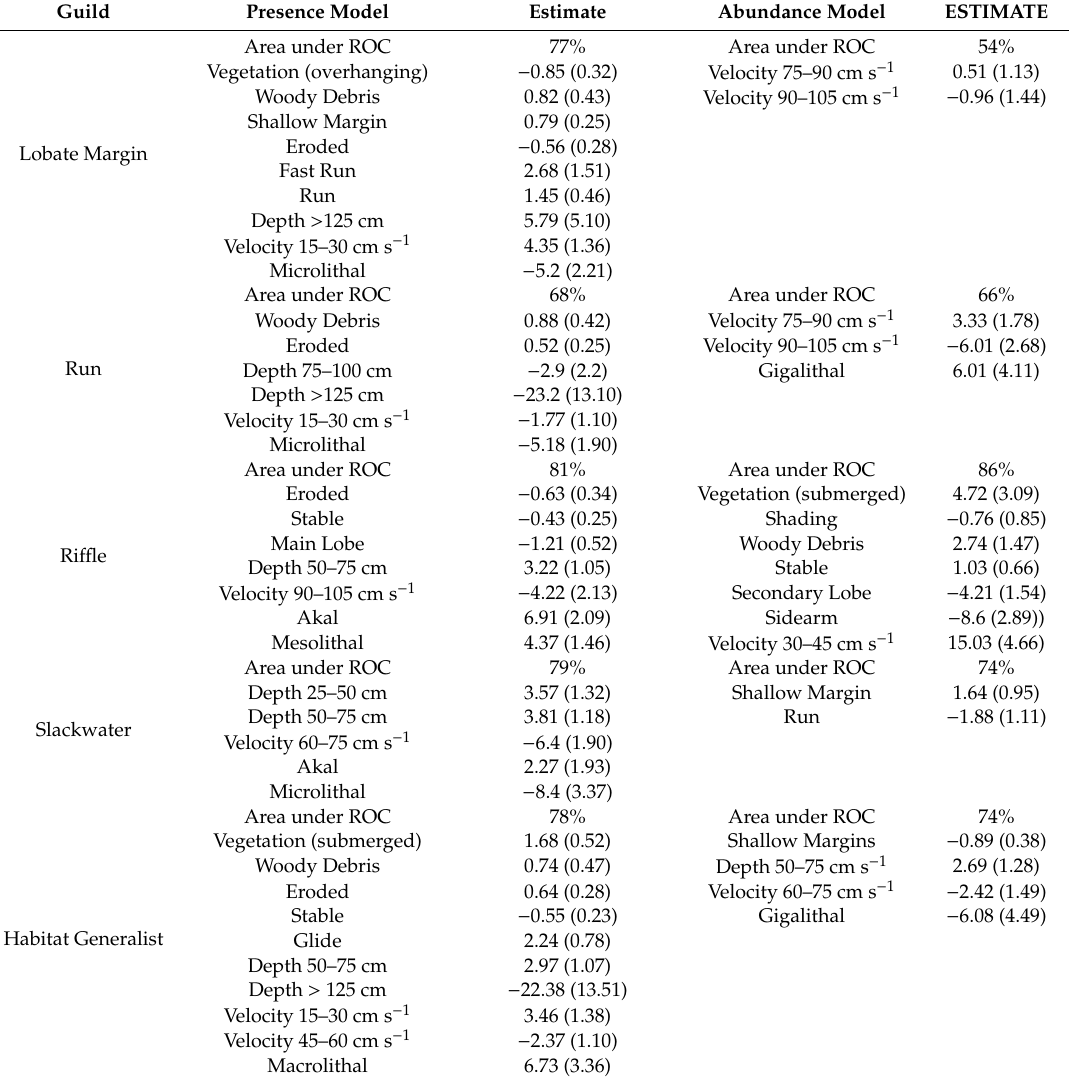
Table 2. Multiple logistic regression model results for each habitat guild including area under receiver operator curves (ROC) and beta values of habitat characteristics associated with presence and abundance models to determine suitability and optimal habitat conditions in the Niobrara River. Values in parentheses indicate standard